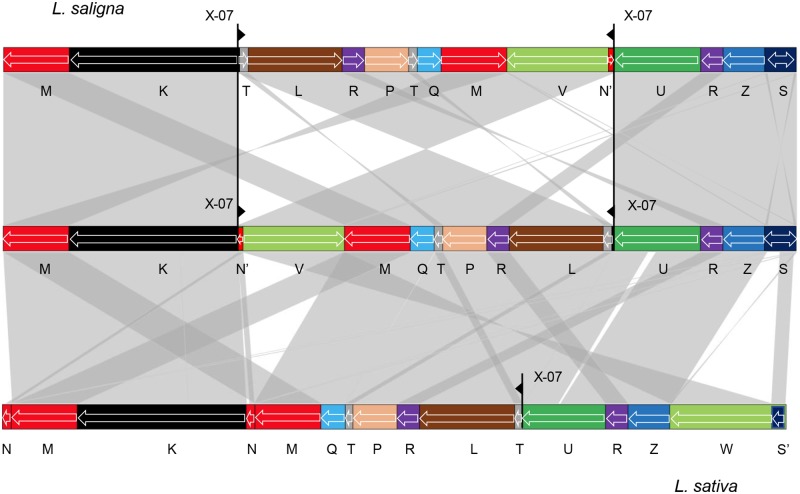
Interconversion between L. sativa and L. saligna genomes.Linear representation of one of the L. saligna major mitochondrial genome isoforms (GenBank accession MK759657) on the top. The middle structure is a putative minor isoform of L. saligna derived from recombination at repeat X-07 (black triangles), which leads to a similar arrangement of primary structural units as that of L. sativa major isoform α at bottom (GenBank accession MK642355). Collinear segments (longer than 500 bp) are indicated by gray shading.